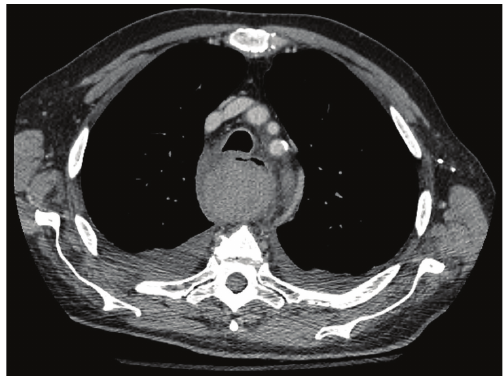
Figure 3: Repeat CT scan of a Posterior Mediastinal Hematoma measuring 4.6cm × 4.6 cm × 18.5 cm, two days after patient presentation to